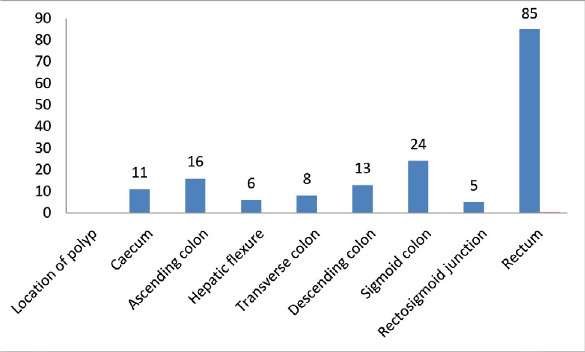
Figure 3. Location of